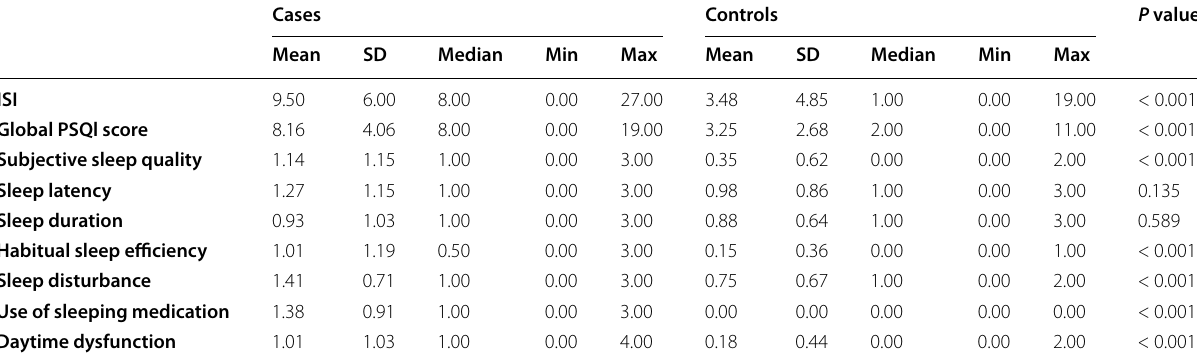
Table 2 Insomnia and quality of sleep among cases and control Cases Controls